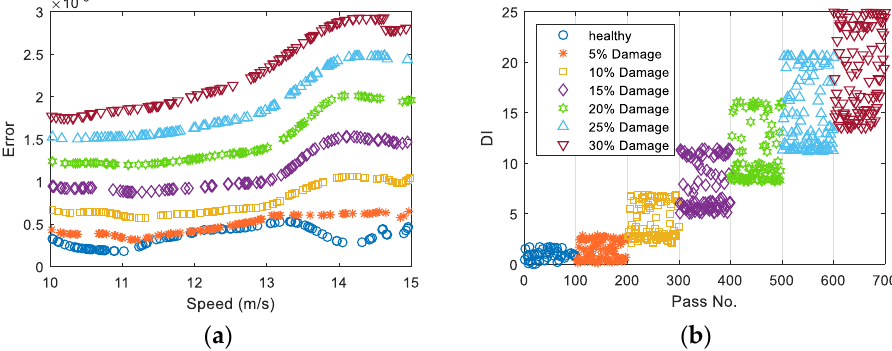
Figure 13. ( a ) The prediction errors and ( b ) the DI for the healthy and damaged